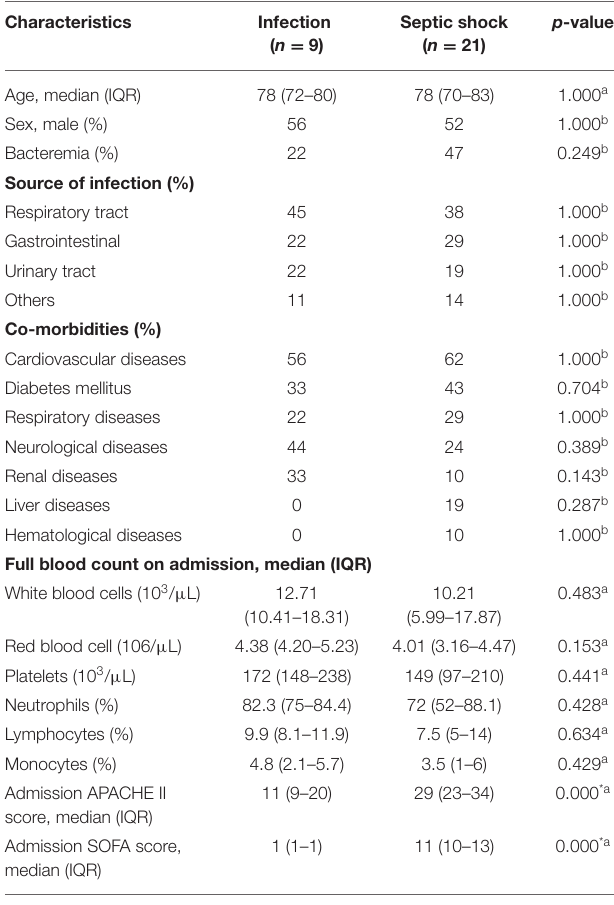
TABLE 1 | Basic characteristics of study subjects † ( n =